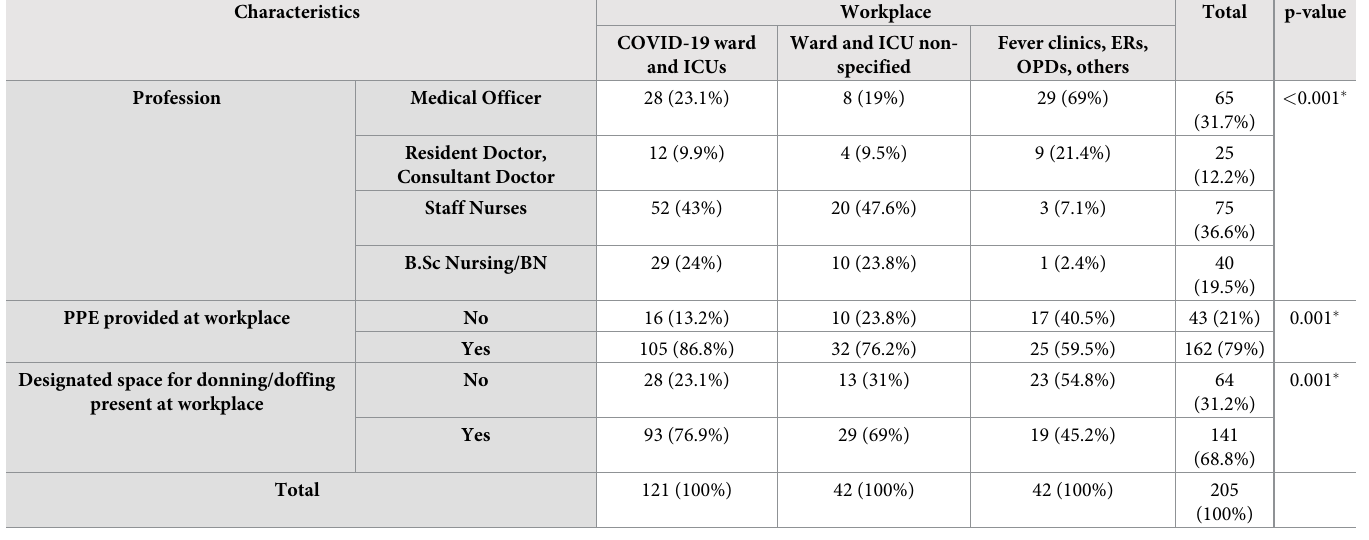
Table 2. Distribution of profession, PPE and designated space by workplace (n = 205).